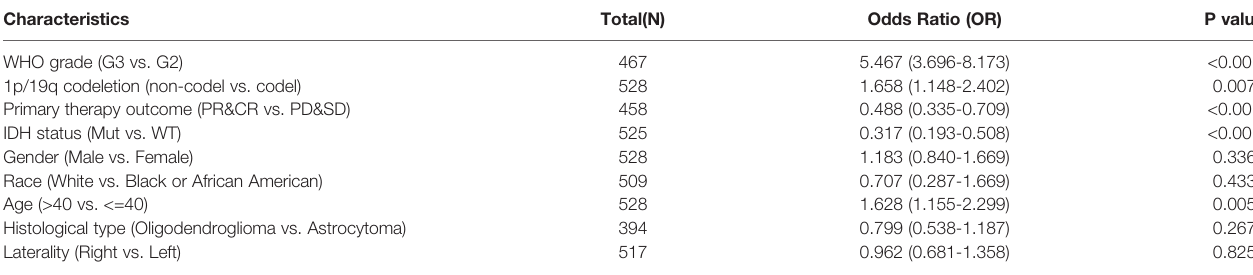
TABLE 2 | The relationship between NCAPG clinicopathologic characteristic in the glioma. Characteristics WHO grade (G3 vs.